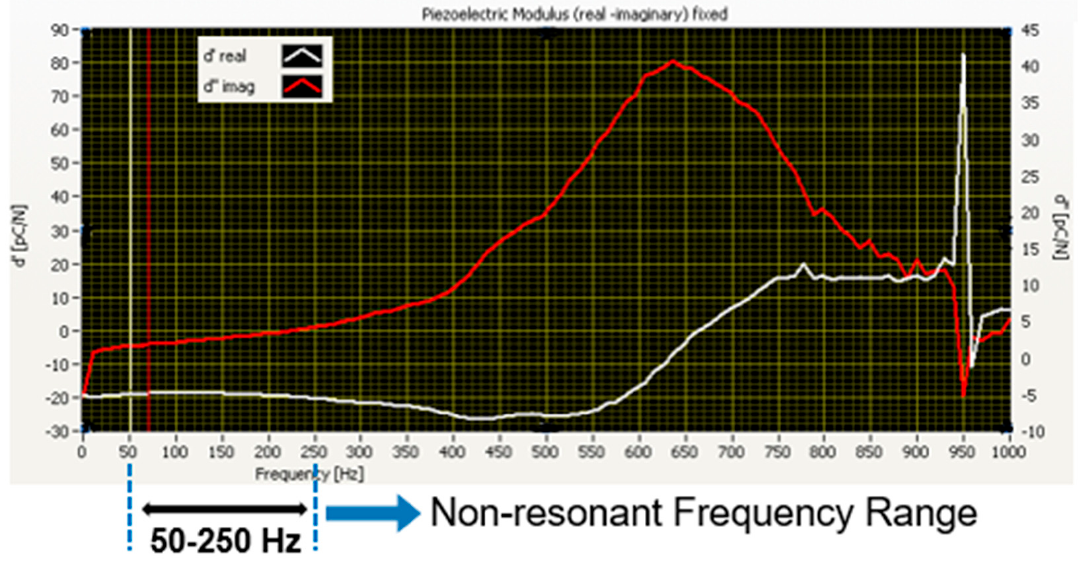
Figure 10. Example of the frequency behavior of both the real (white curve) and imaginary (red curve) part of the d 33 piezoelectric coefficient. The scale for the Im (d 33 ) (= d’’) is on the right y -axis.